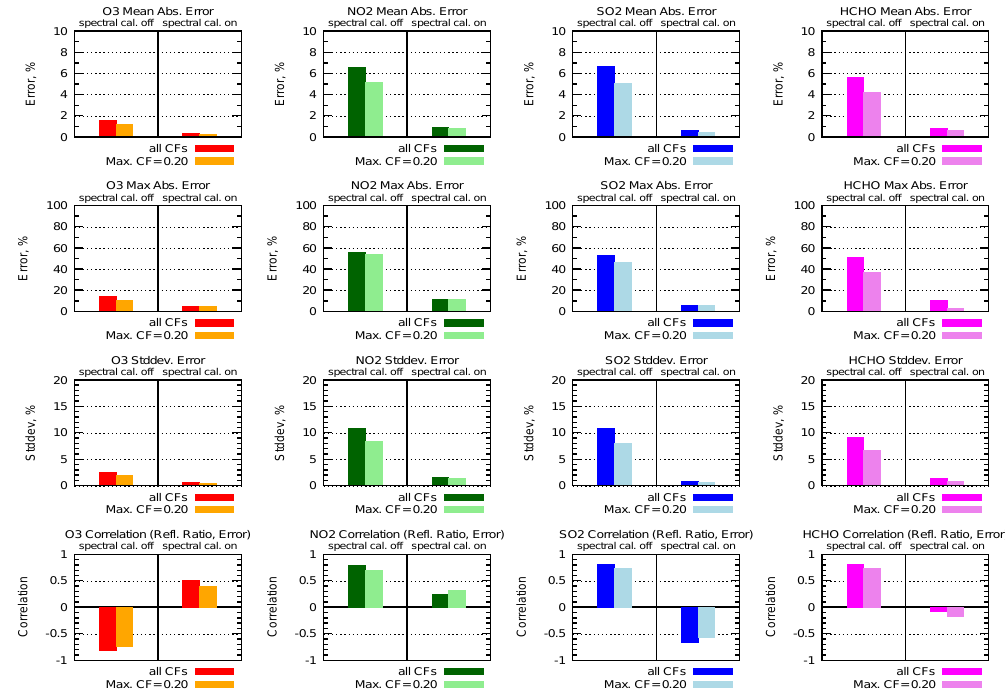
Fig. 7. Estimated errors of O 3 (red/orange), NO 2 (green), SO 2 (blue) and HCHO (magenta). Top row: mean error; 2nd row: maximum error; 3rd row: standard deviation of error; bottom row: correlation with the reflectance ratio. Values are given with and without spectral calibration, and for different maximum cloud fractions (CFs 100% and